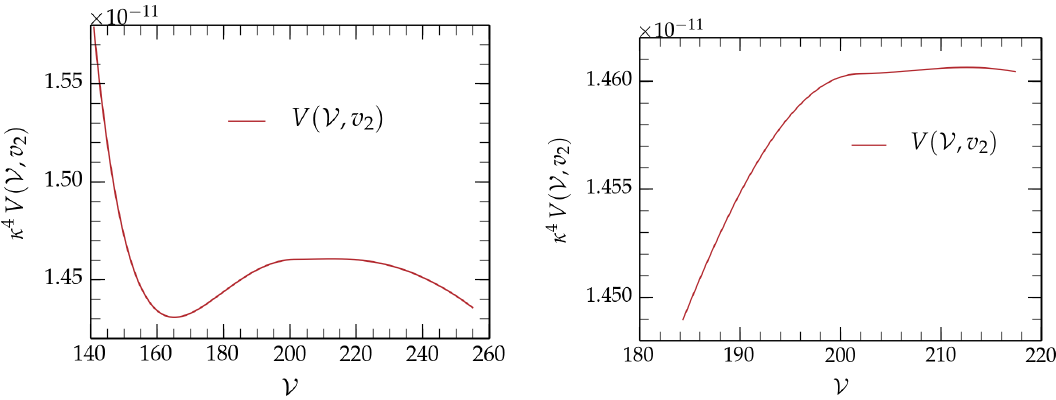
Figure 1 . Value V ( V , v 2 ) of the global minimum of the scalar potential as a function of the internal volume, for the parameters of